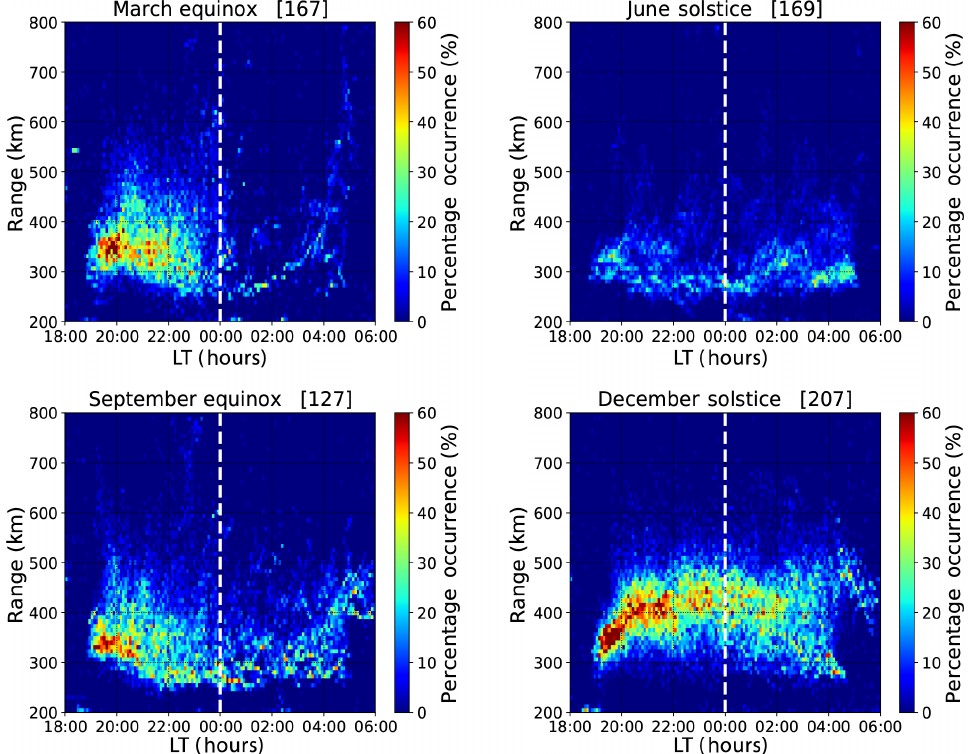
Figure 8. Percentage occurrence of plasma plumes as a function of local time and height for the years 2014–2018. Each panel represents a season. The number indicated in brackets is a count of days used to generate each season’s statistics when measurements were made. The dotted white vertical line represents